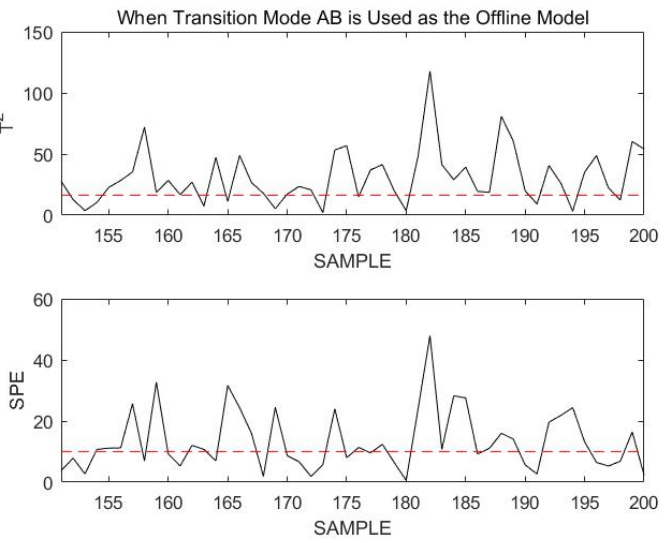
Figure 19. Monitoring 151st to 200th sample points using transition mode AB as an offline model.